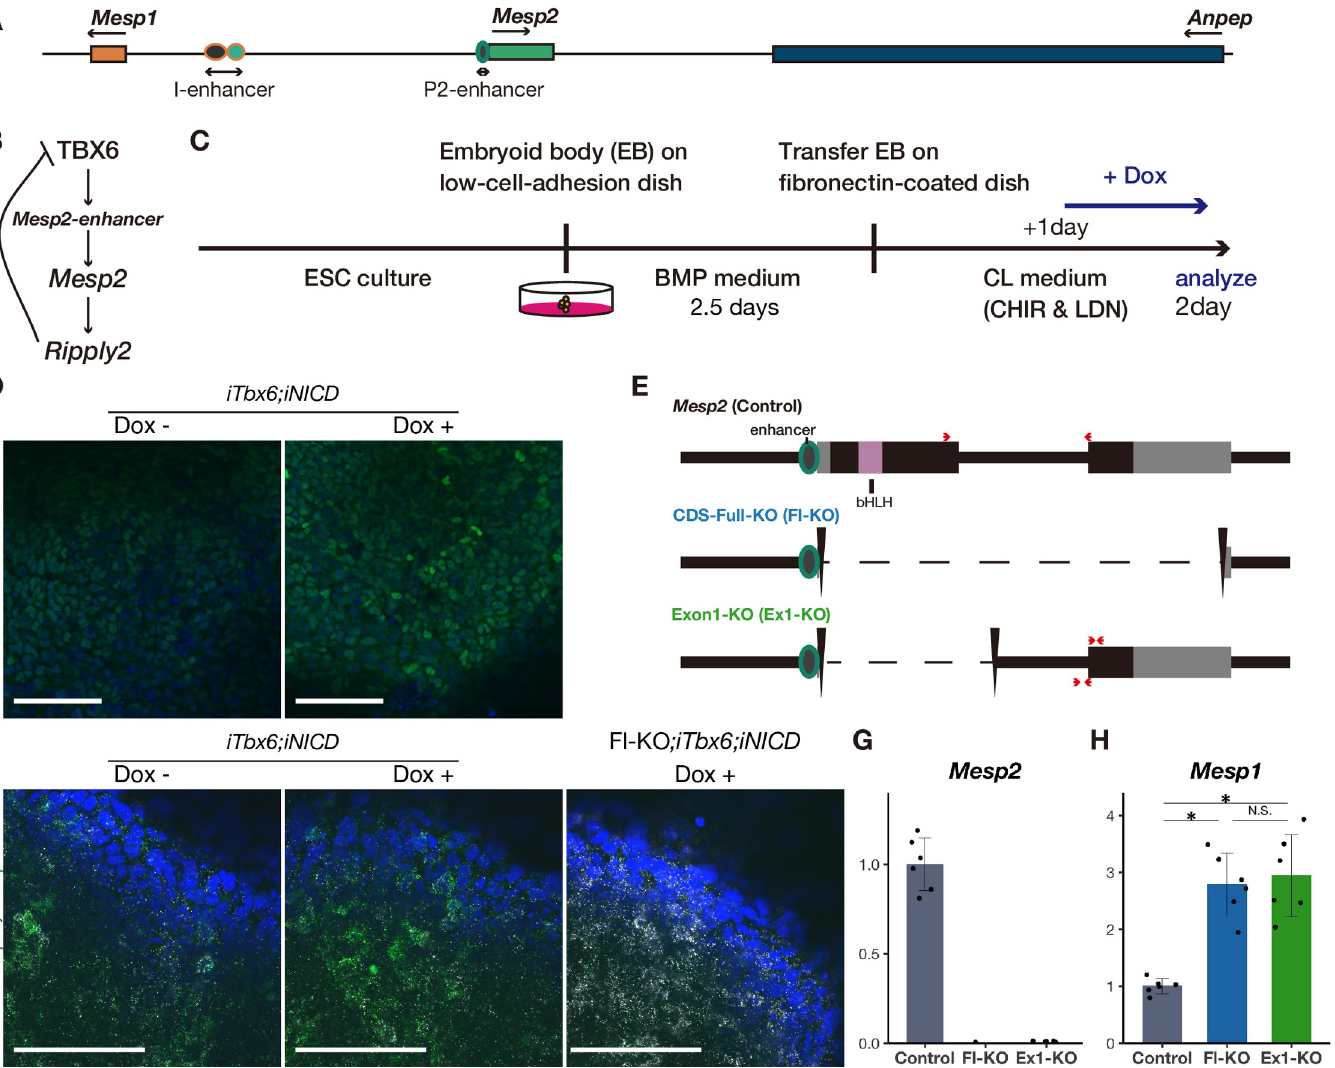
Fig 1. Reproducing the PSM and compensatory response of Mesp genes in vitro . A Schematic diagram of the genome at the Mesp2 locus and enhancers. B Schematic diagram of reciprocal regulation of Mesp2 . C Schedule of in vitro PSM induction from ES cells for optimal induction of Mesp2 . D Immunostaining of TBX6 in the in vitro PSM of iTbx6;iNICD with (right) or without (left) Dox administration. Scale bars: 100 μ m. E Schematic diagram of Mesp2 coding sequence deletions. Red arrows indicate the primers used for qPCR. Primers at Mesp2 (wild-type), which detect only spliced Mesp2 , were used for most experiments. Primers at Exon1-KO were used for precursor RNA and either precursor or mature RNA of Mesp2 , as used in Fig 2A. F In situ hybridization for Mesp1 (white) and Mesp2 (green) in the in vitro PSM of iTbx6;iNICD without (left) or with (middle) Dox administration, and iTbx6;iNICD ; Mesp2 -CDS-Full-KO upon Dox administration (right). Scale bars: 100 μ m. G, H qPCR analysis of Mesp2 (G) and Mesp1 (H) in the in vitro PSM (n = 6 cultures for each genotype). The expression levels are presented as the ratio against iTbx6;iNICD line (control). P - values were calculated by the Mann-Whitney U test comparing iTbx6;iNICD (control) and iTbx6;iNICD ; Mesp2 -KO lines. Data are presented as the mean ± SD. Asterisk indicates significant (p <